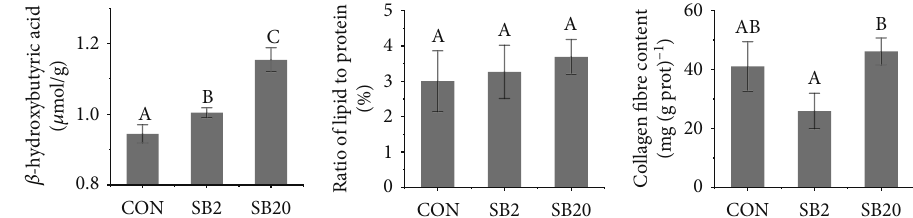
Figure 2: E ff ects of two dosages of sodium butyrate on liver biochemical indices of largemouth bass, Micropterus salmoides. Di ff erent letters above the bars represent signi fi cant di ff erences ( P < 0 : 05 , n = 3 ).